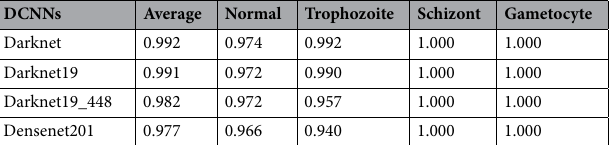
DCNNs Average Normal Trophozoite Schizont Gametocyte